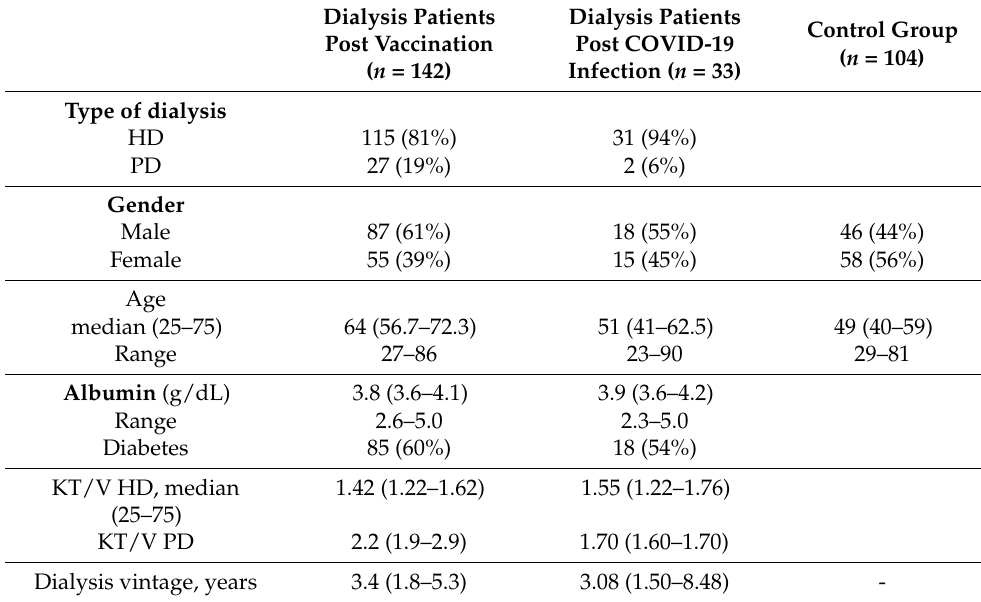
Table 1. Patient